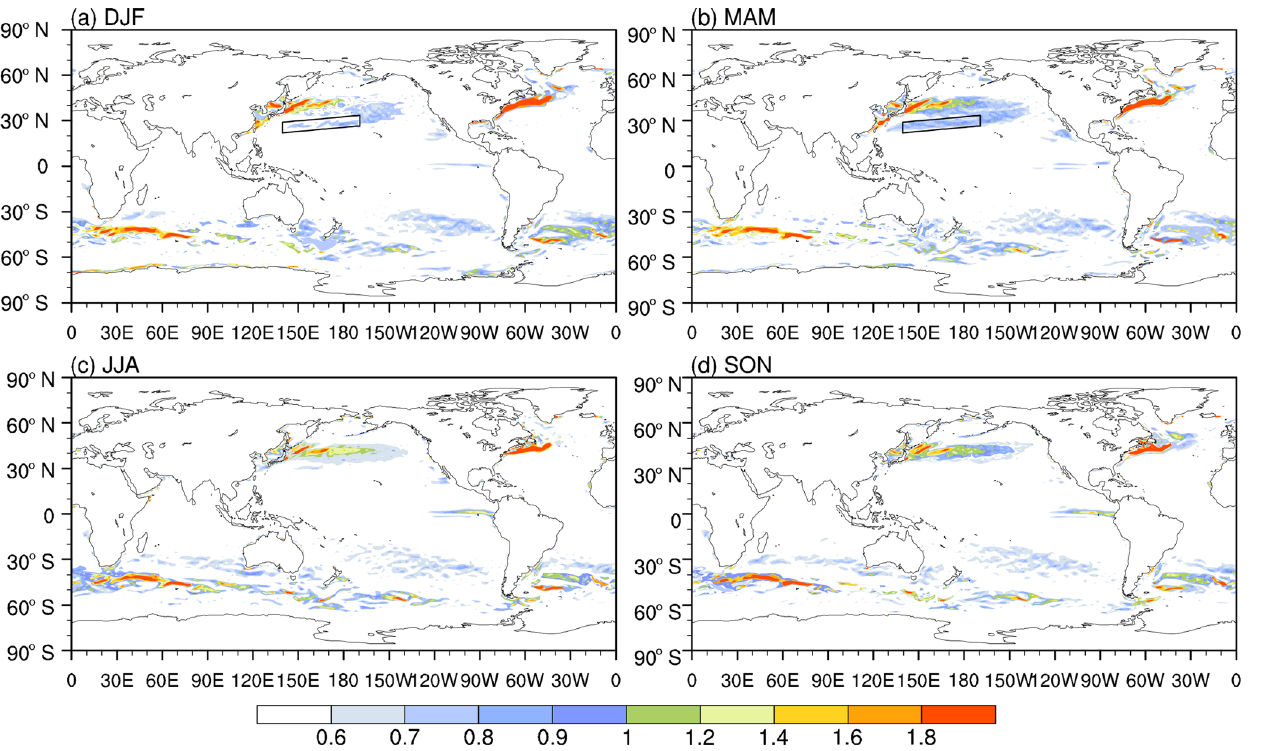
Figure 1. Climatological meridional SST gradients ( | ∂ SST /∂y | , units: ◦ C(100km) − 1 ) in (a) winter, (b) spring, (c) summer and (d) autumn. Winter refers to the time period of December in the preceding year and January–February in the current year (DJF). The spring, sum- mer and autumn refer to the time periods March–Apil–May (MAM), June–July–August (JJA) and September–October–November (SON), respectively. The black boxes in (a) and (b) indicate the key area of the NPSTF.